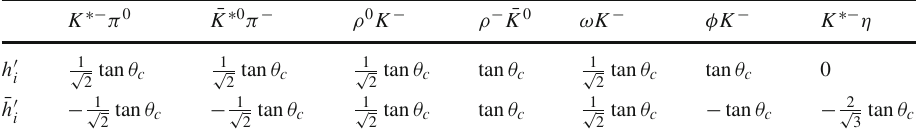
Table 3 Same as Table 1 but for I = 1 / 2.( θ c is the Cabibbo angle, tan θ c = 0 .